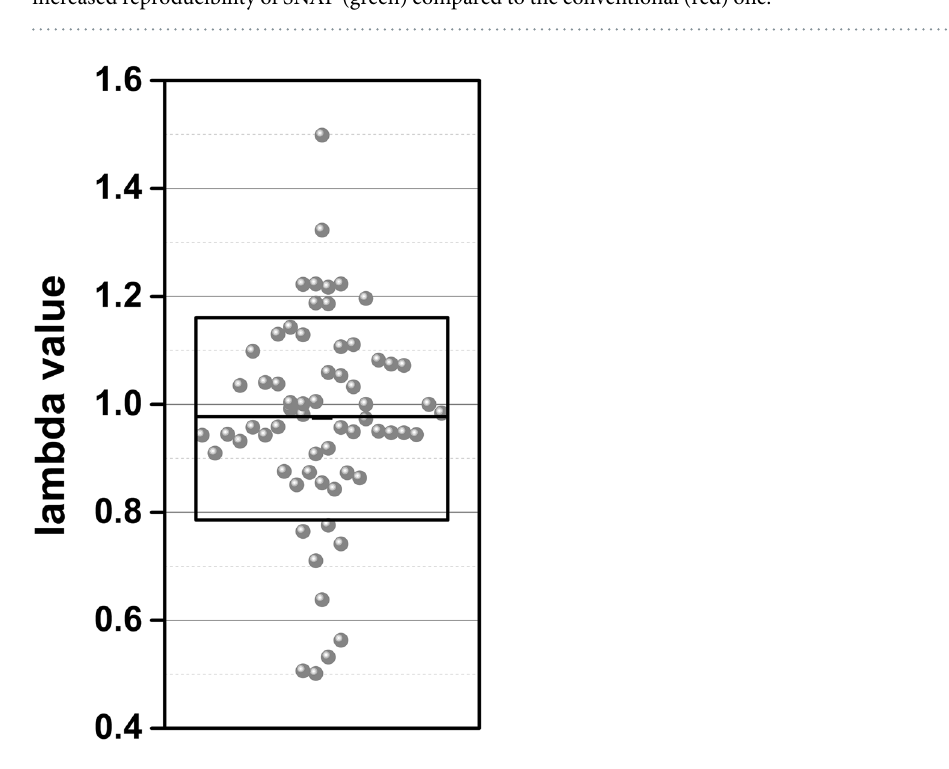
Figure 3. Mechanical properties of MDCK C11 cells. Elastic moduli were determined by participating labs with and without the application of SNAP (using the deflection sensitivity extracted from AFM thermal spectra with Java applet). Data represent peak value and the width of the histograms of Young’s moduli determined by fitting a Gaussian function locally around the peak value (see Methods section for details). The average and standard deviation of all typical values for each lab (i.e. each cell sample) are depicted as colour bars showing the increased reproducibility of SNAP (green) compared to the conventional (red) one.